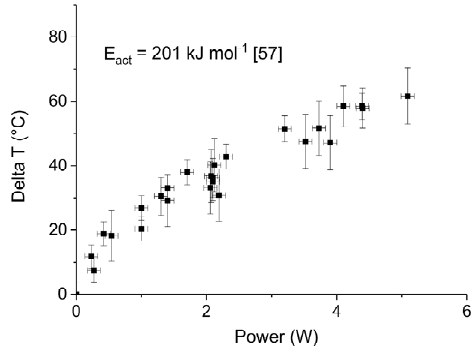
Figure 11. Average increase of temperature in the plasma zone as function of power during the CaCO 3 decomposition previously shown.